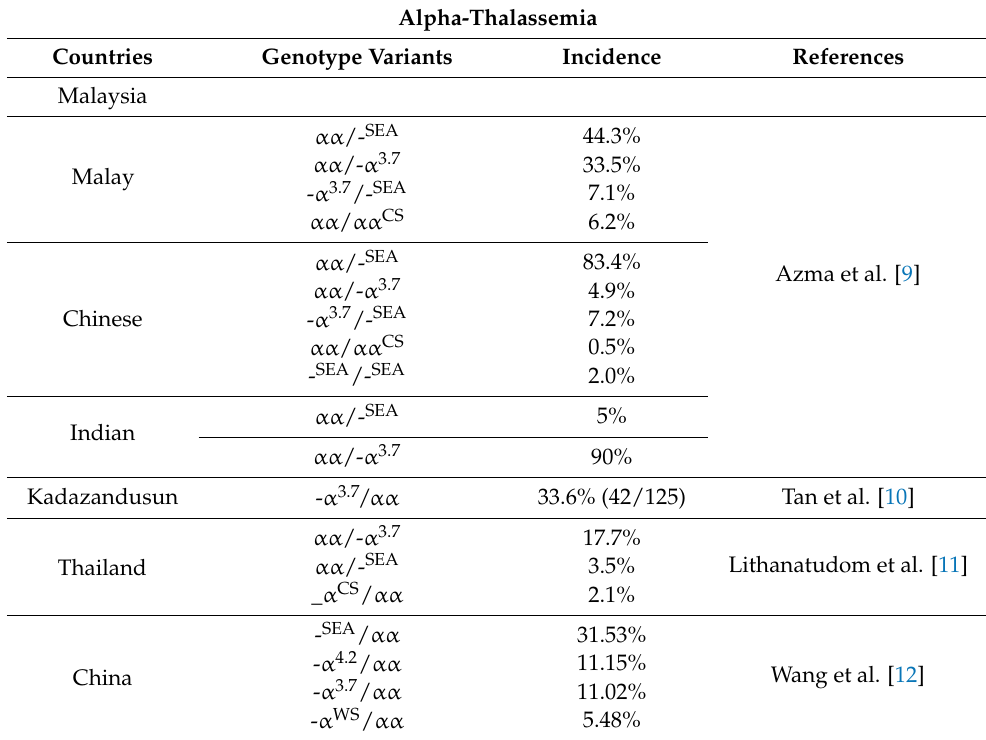
Table 1. Incidence of alpha- and beta-thalassemia across several developing